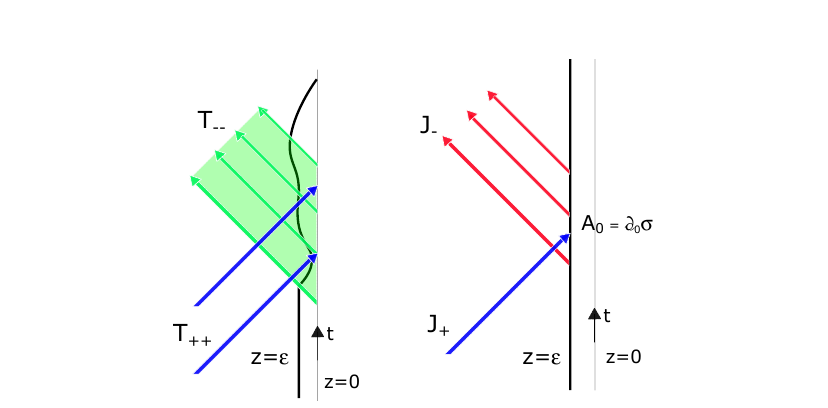
Figure 9 . Scheme of theories and their interrelation.